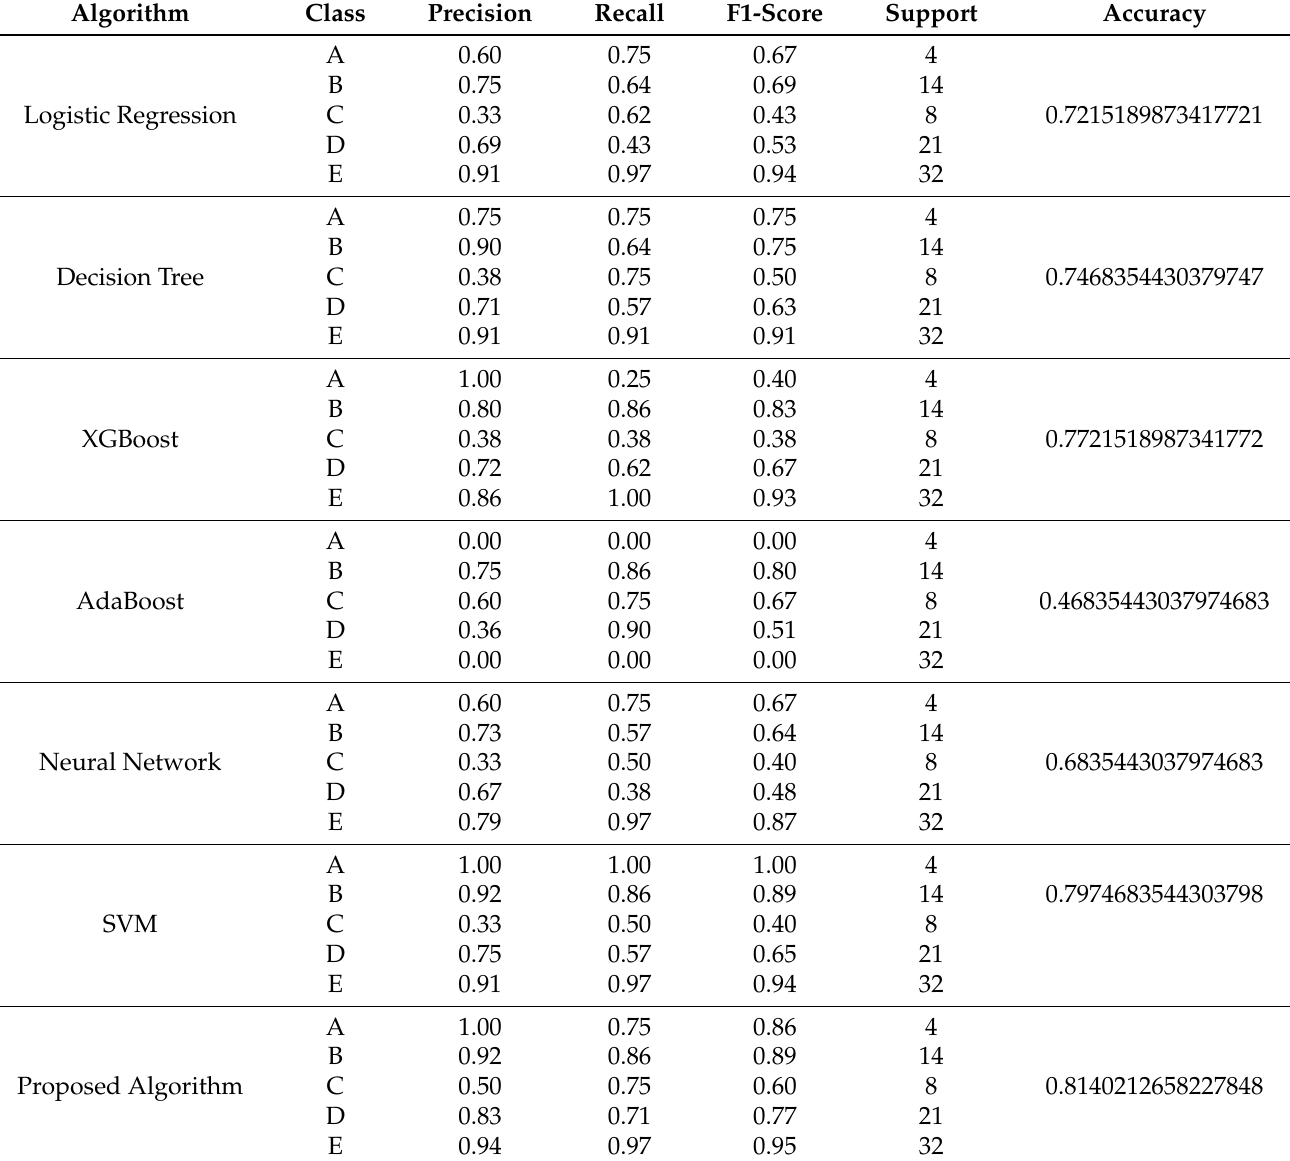
Table 4. Comparing results with all experimental algorithms on the student performance